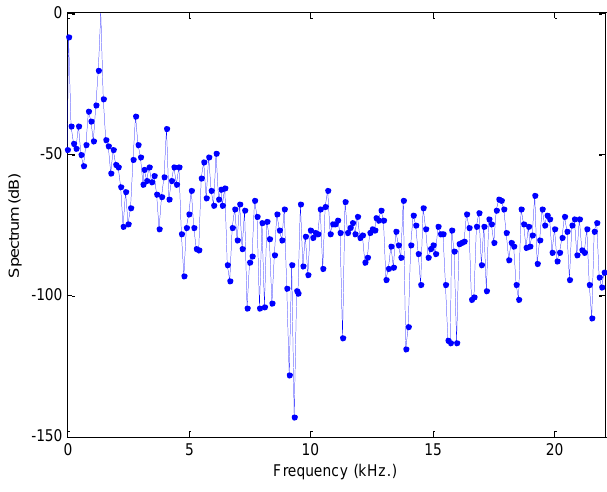
Figure 7. Typical spectrum of an anuran sound frame.